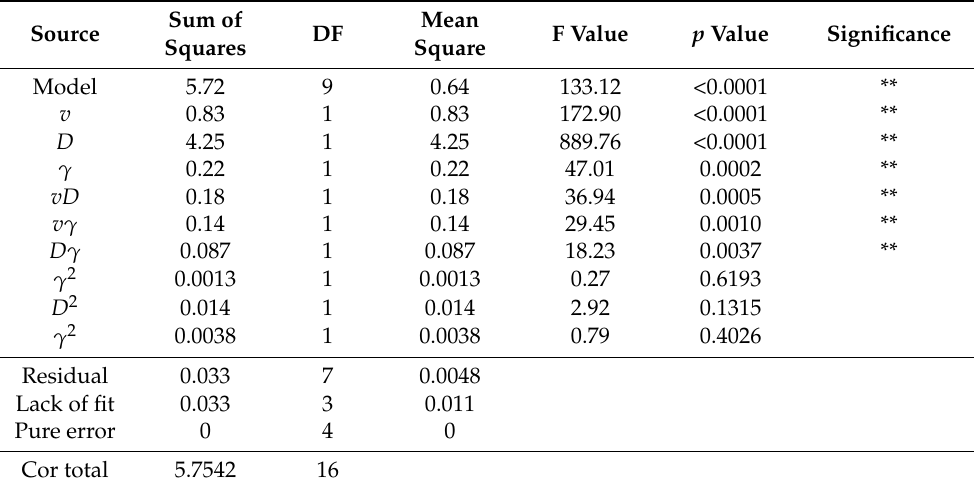
Table 5. ANOVA of the simulated draught force of